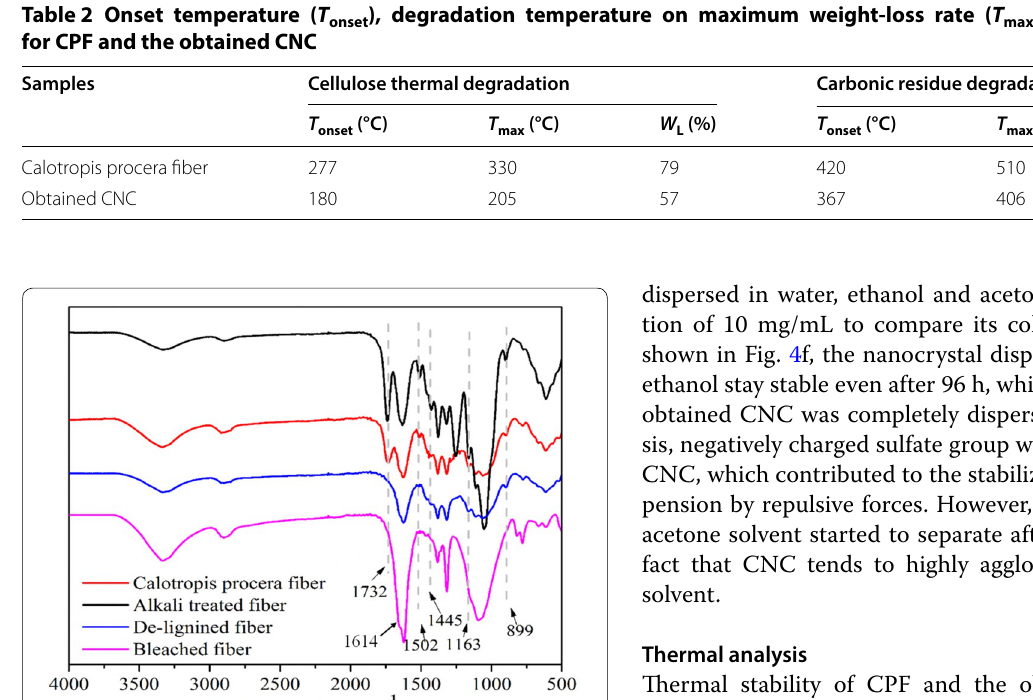
), degradation temperature on maximum weight-loss rate ( T onset